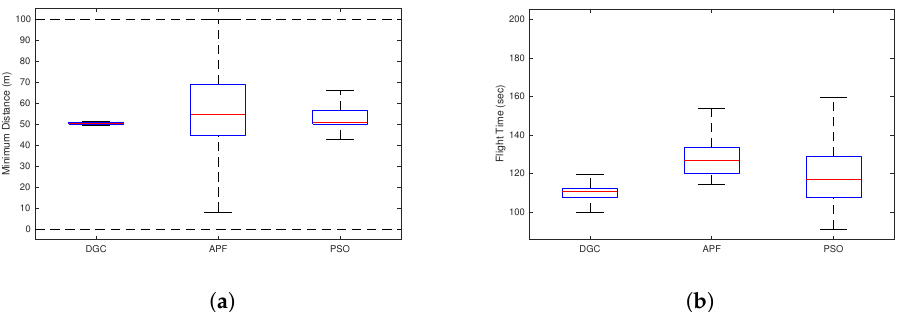
Figure 6. Monte-Carlo simulation comparison. ( a ) Minimum distance. ( b ) Total flight time. Table 2. Simulation